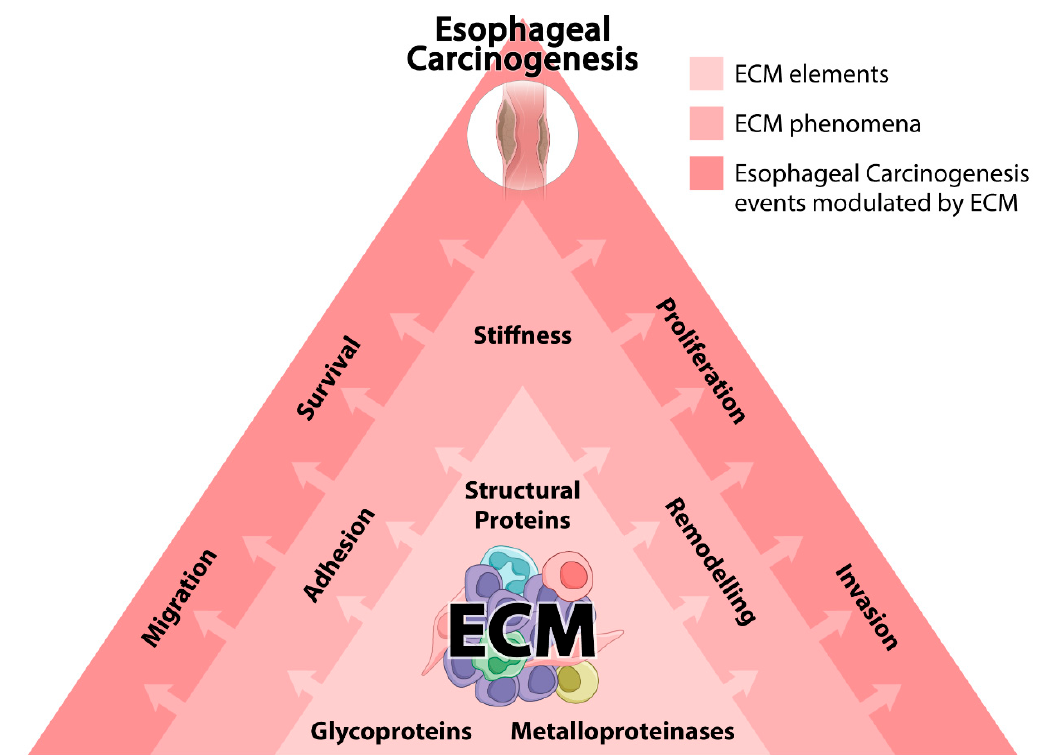
Figure 1. Extracellular matrix (ECM) and esophageal carcinogenesis. The figure schematically represents how ECM may affect the genesis and/or development of esophageal tumors. The first layer represents the main classes of ECM constituting proteins involved in esophageal carcinogenesis. The second layer represents ECM phenomena modulated in esophageal tissues as a consequence of the altered protein constitution and function of this compartment. The third layer represents the crucial cellular events impacted by structural and functional alterations occurring in ECM, which may play a crucial role in esophageal carcinogenesis. Arrows indicate the dynamism and hierarchy between the three layers of events.